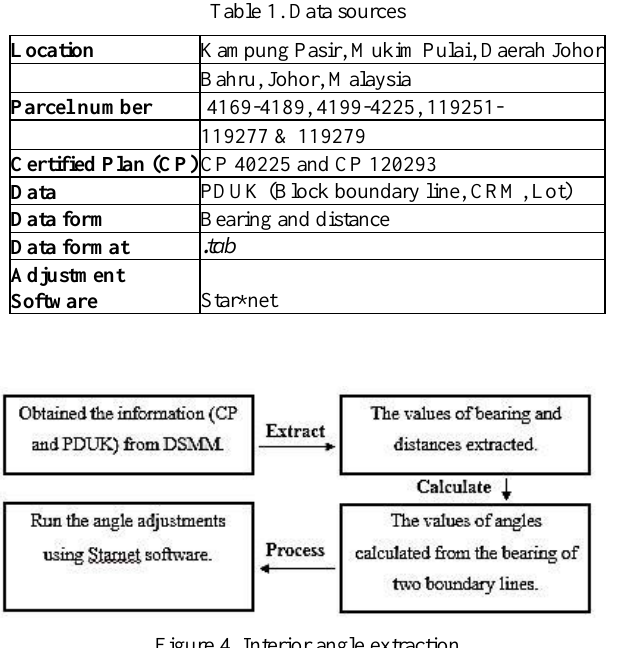
Figure 4. Interior angle extraction